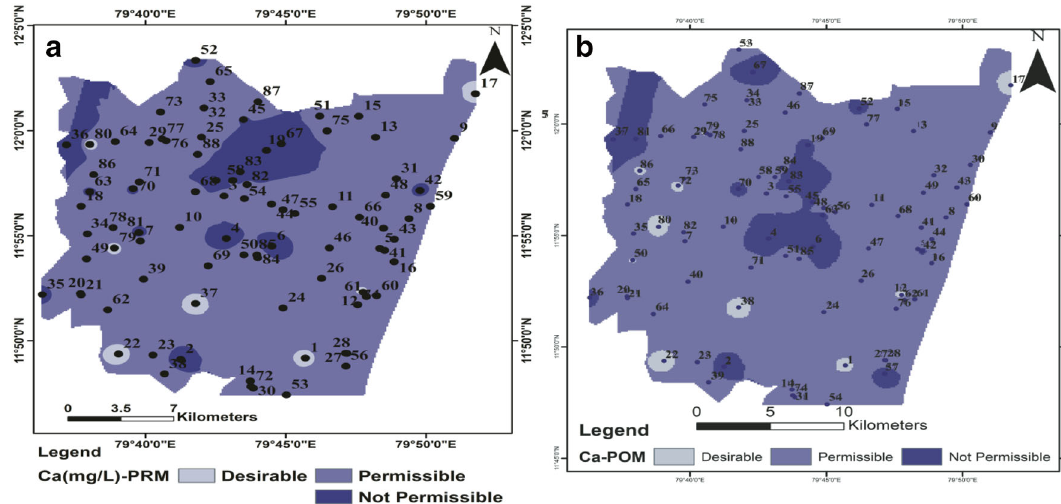
Fig. 8 a , b Spatial distribution map of Ca (pre- and